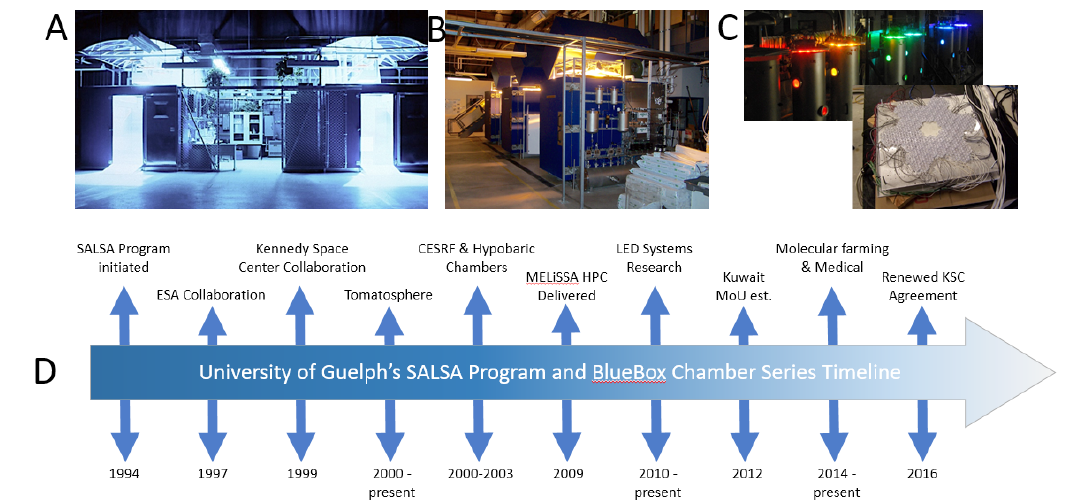
Figure 1: Space Agriculture Research at the University of Guelph. A) The first Controlled Environment Plant Production Chambers at the University of Guelph dedicated to space exploration related research. B) Canopy-scale hypobaric plant growth chambers as part of the Controlled Environment Systems Research Facility (CESRF). C) Advanced LED Lighting system development; a key part of the CESRF advanced